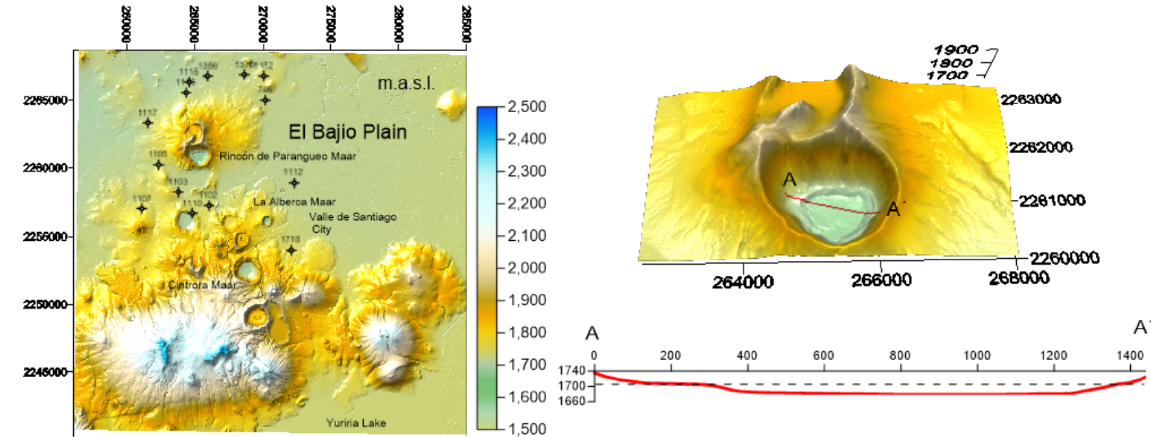
Figure 1. Digital elevation model obtained by LIDAR data from INEGI (Institute of Informatics and Geography; Mexico) showing the volcanic cluster in the area of Rincón de Parangueo maar. Perspective view of the crater and the annular fault system affecting the bottom. Topographic profile crossing the crater showing the initial lake surface (dashed line) and the present day leveling (red